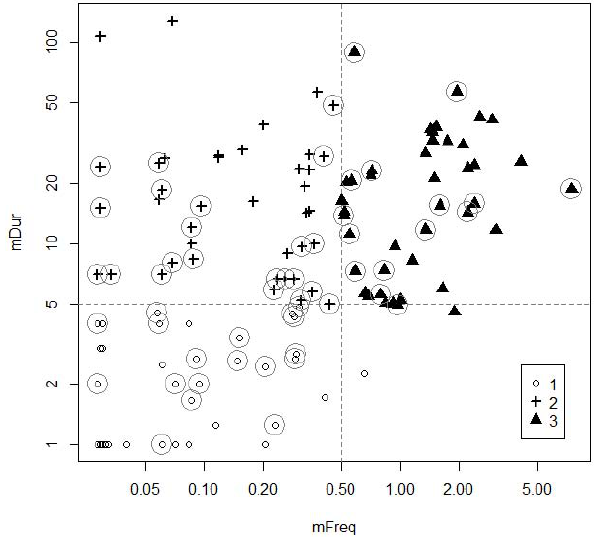
Fig. 5. Intermittence index values for gauging stations on intermit- tent segments. Three intermittence subclasses are indicated by dif- ferent symbols. Subclasses were defined using threshold values of mFREQ and mDUR (dashed lines). Sites that were misclassified by the RF model are indicated with gray circles.